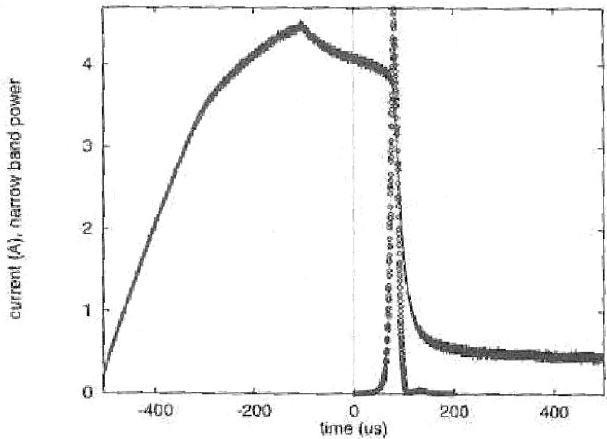
FIG. 9. (Color) PSR threshold rf voltage versus bunch intensity [80]; the historical curve reflects the situation before the ex- tended 2001 run, the other three curves refer to three different injected bunch lengths (200, 260, and 290 ns) at the end of this